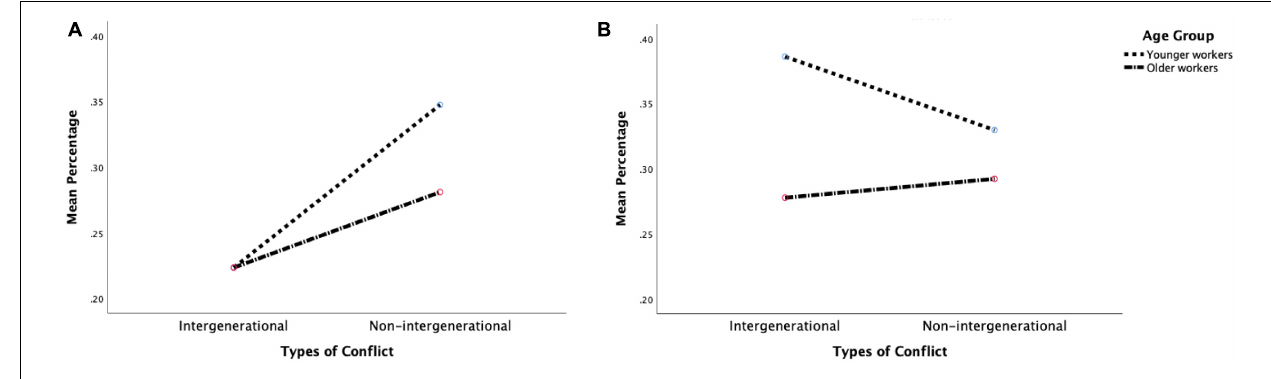
FIGURE 2 | Interaction effects between conflict type and age group on visual attention on the main actor (A) and coworker (B) .